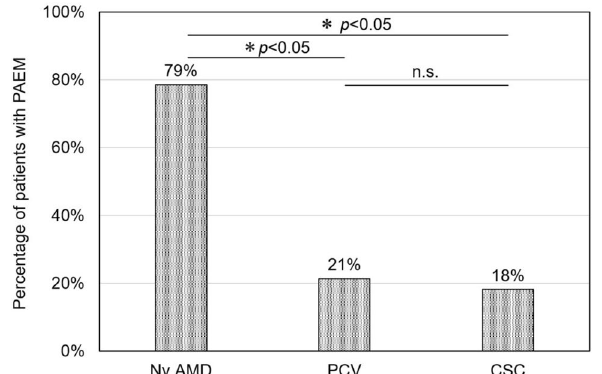
Figure 4. Incidence of PAEM by disease subtype. The incidence of PAEM was 79% in nAMD, 21% in PCV, and 18% in CSC. In a multiple comparison of the three groups, nAMD had a significantly higher incidence of PAEM compared to PCV and CSC (nAMD versus PCV: p < 0.05, nAMD versus CSC: p < 0.05, PCV versus CSC: p =